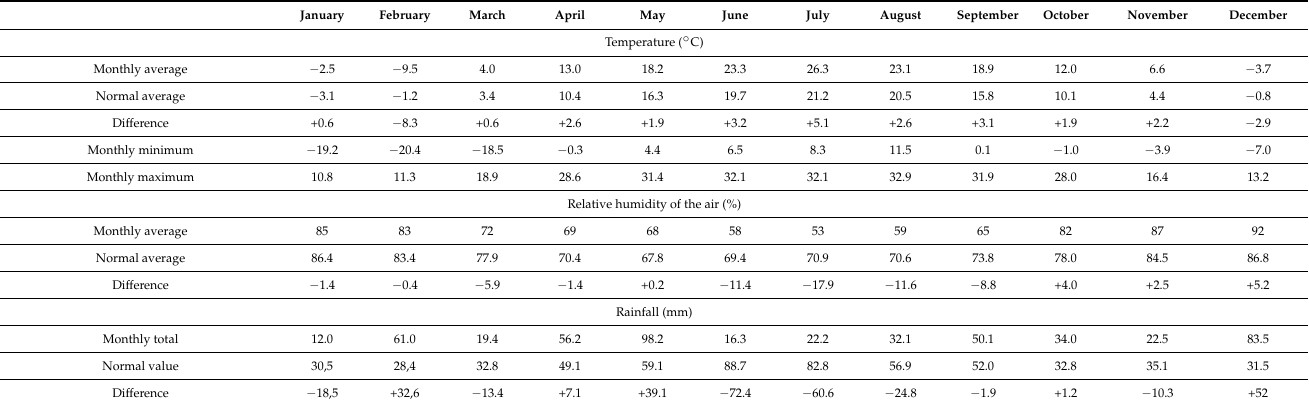
Table 2. Climate data for